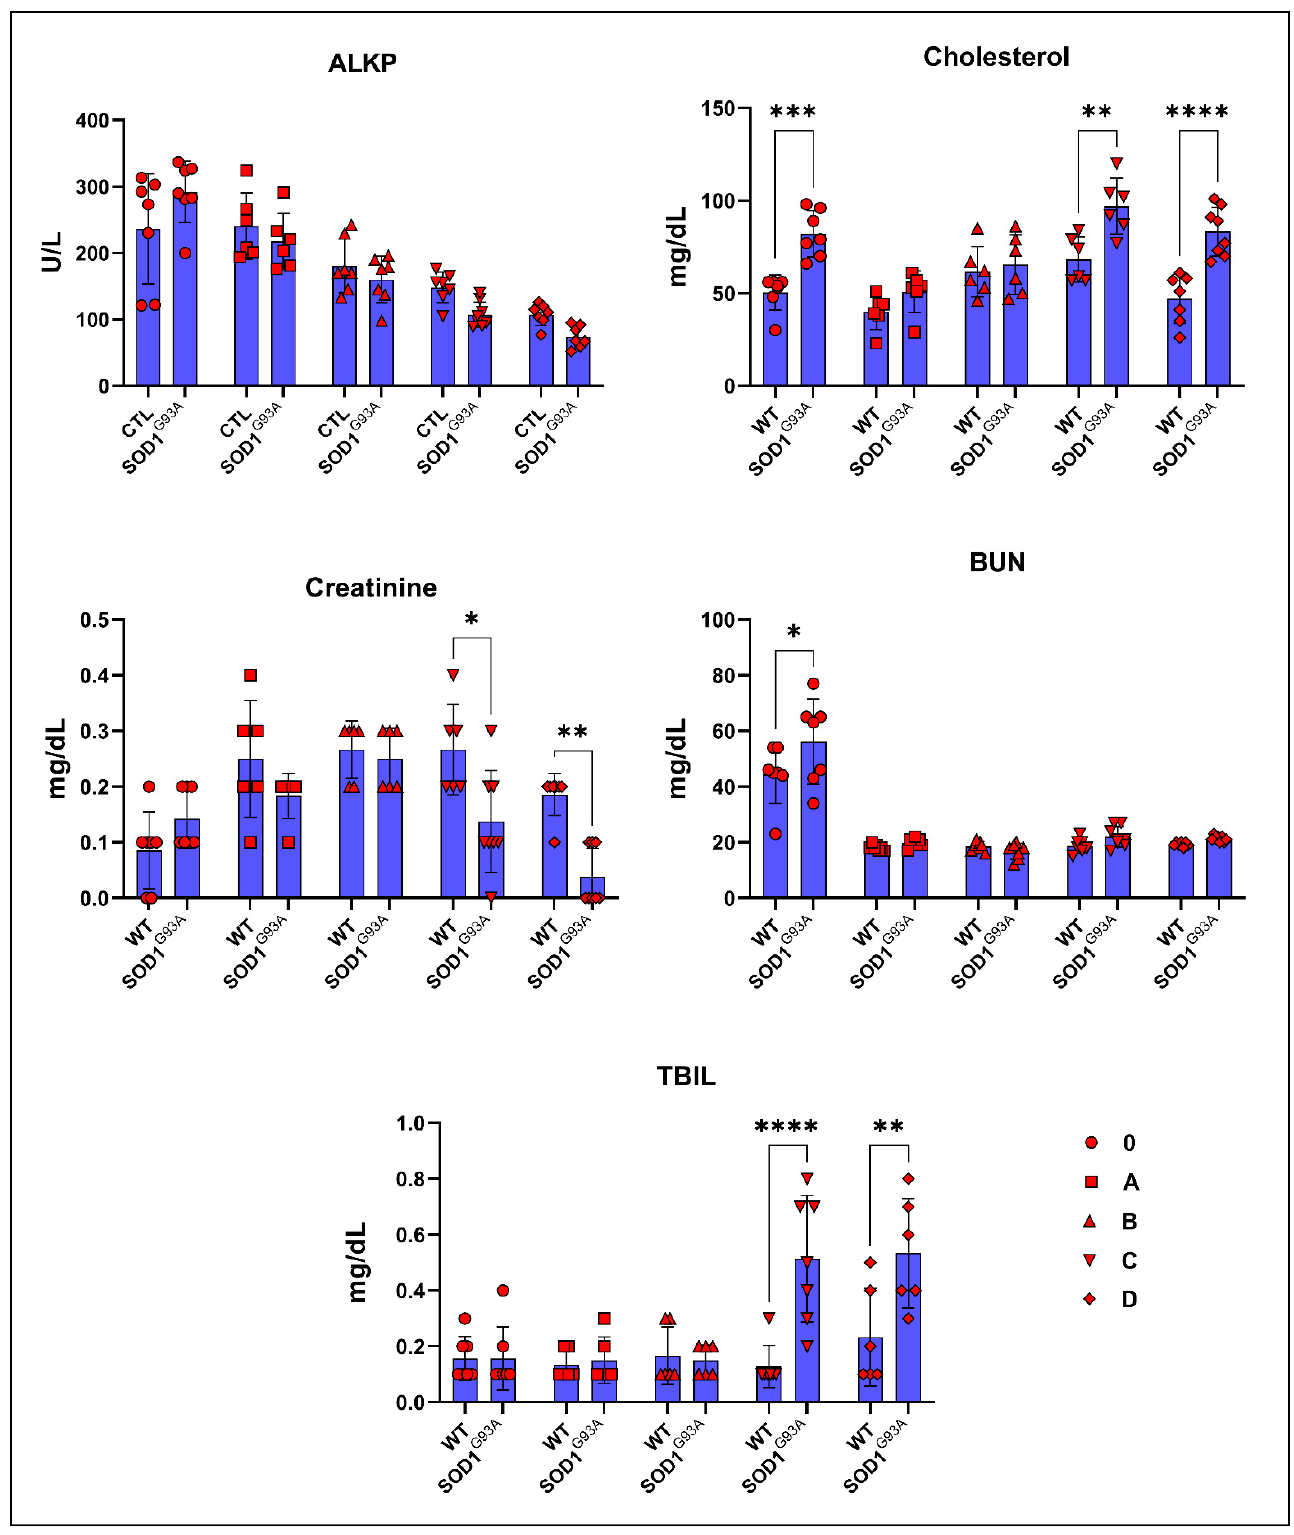
Figure 2. Serum biochemical parameters of the SOD1 G93A and SOD1 WT rats. All results were given as mean ± SD of n = 6–8 animals for each group. Notes: * p ≤ 0.05, ** p ≤ 0.01, *** p ≤ 0.001, and **** p ≤ 0.0001.